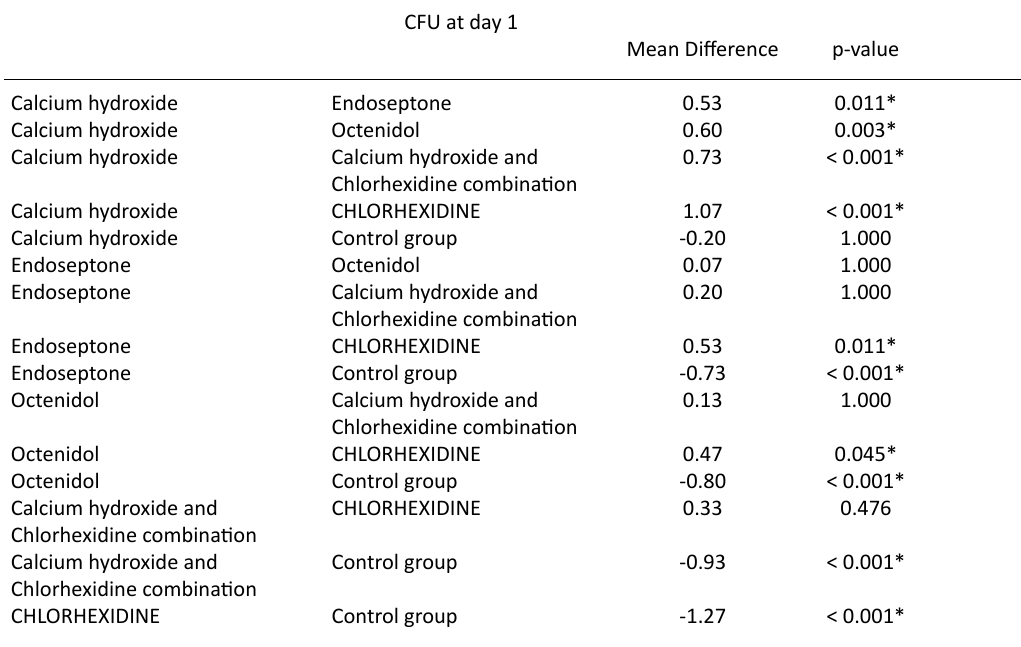
Table 6. Difference of CFU at day 1, between various medicaments